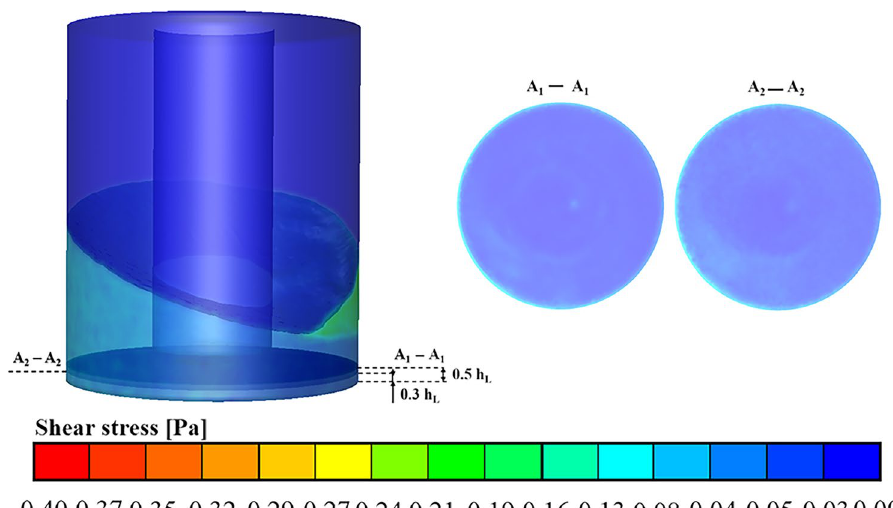
Figure 8. Shear stress distribution of the hollow cylindrical OSR with filling volume of 8 L, shaking speed of 100 rpm and h L = 30 mm was studied. In order to better visualize the shear stress distribution, the local shear stresses of 0.5 h L (A 1 -A 1 ) and 0.3h L (A 2 -A 2 ) sections were intercepted. The magnitude of the shear stress was indicated by different colors based on the color bars shown in the